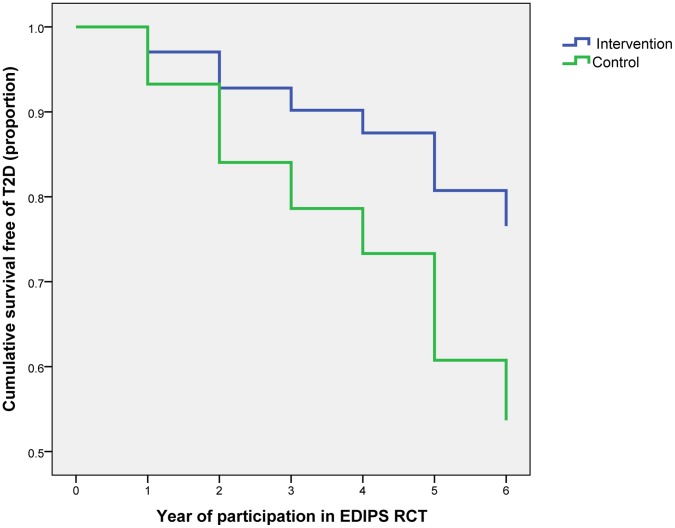
Progression to type 2 diabetes by trial arm.